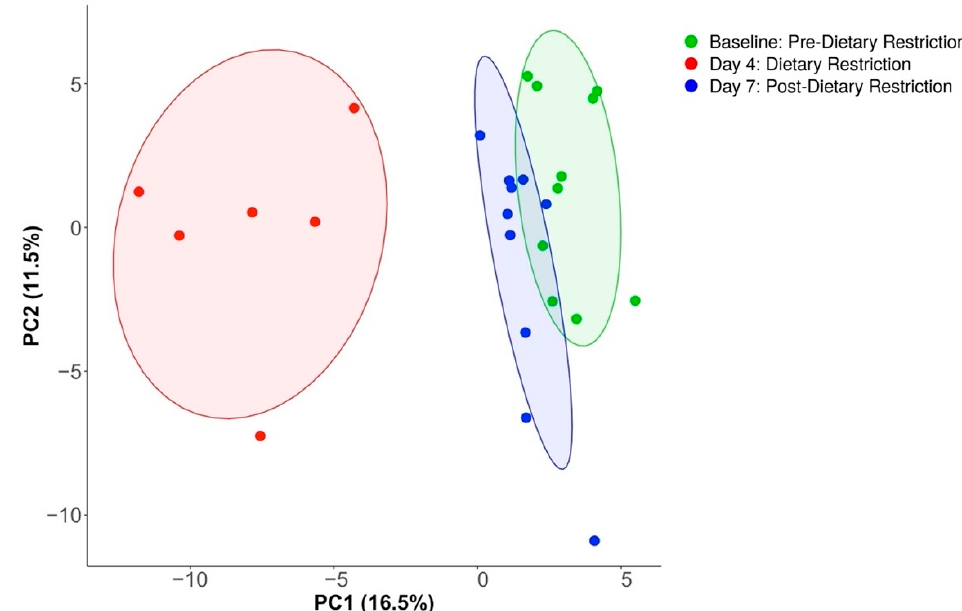
Figure 3. Principal component analysis of species abundance after prevalence filtering. Dietary restriction caused unique species composition, while Baseline and Day-7 conditions showed adjacent clustering, representing group similarities.